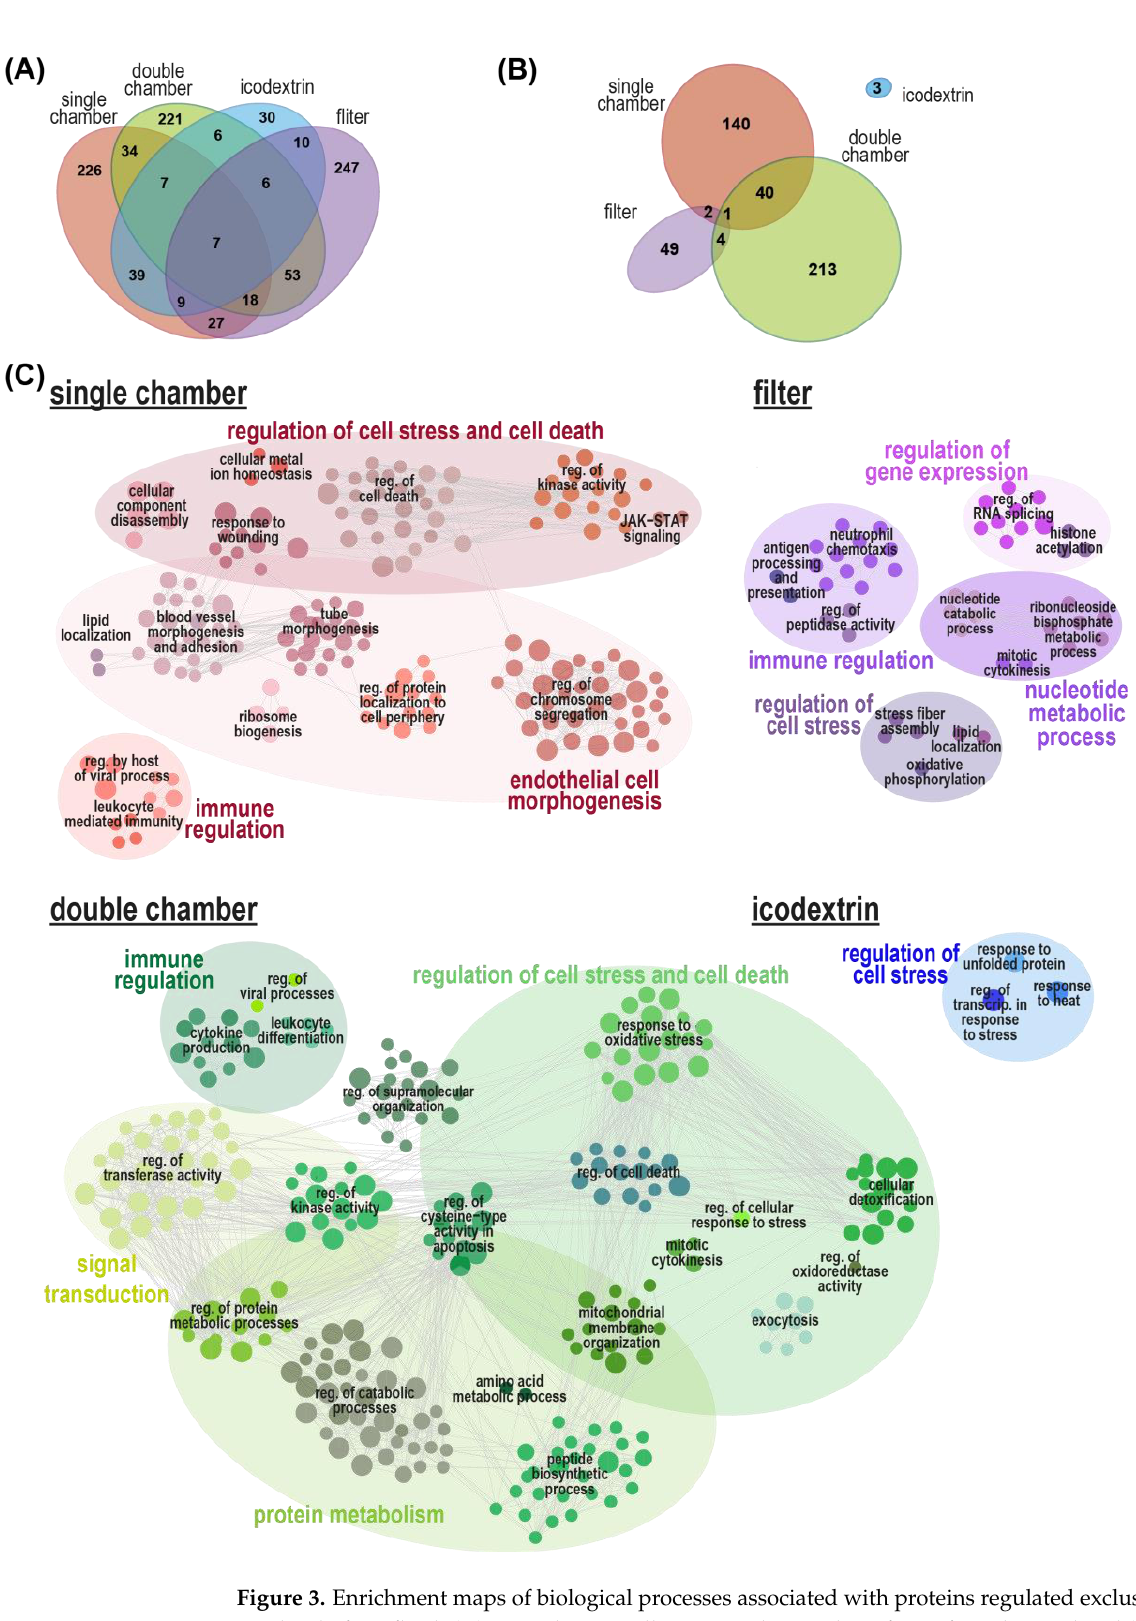
Figure 3. Enrichment maps of biological processes associated with proteins regulated exclusively by one kind of PD fluid. ( A ) Venn diagram illustrating the overlap of significantly regulated (LIMMA, BH p < 0.05, log 2 [fold change] > 0.5) proteins following PD fluid exposure. Only the proteins not overlapping were used for the biological process enrichment analysis. ( B ) Venn diagram illustrating the overlap of significantly enriched gene ontology biological processes analysis of each of the individual groups of proteins regulated by only one PD fluid. ( C )